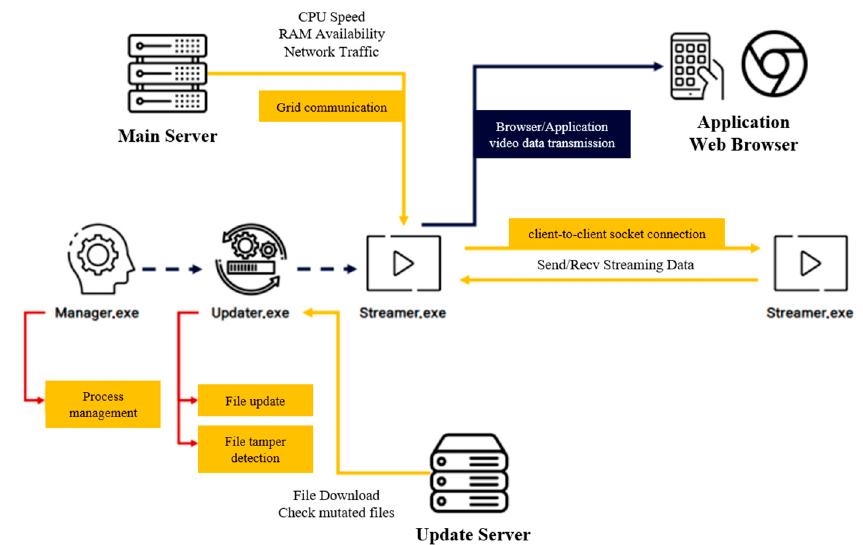
Figure 6. Grid computing operation structure in live-streaming services.